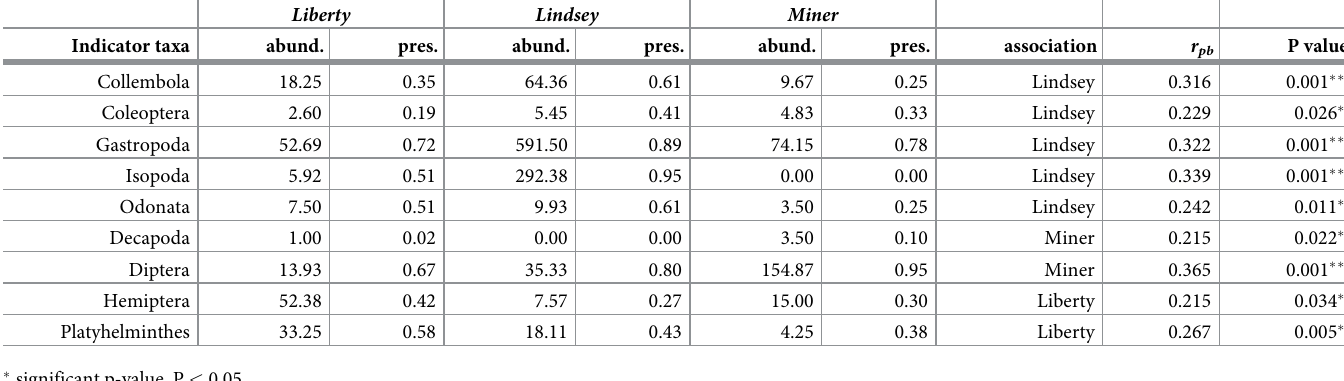
Table 7. Taxa which were significantly associated with a particular area mean abundance by group (abund.), proportion of samples where taxa was present (pres.), and statistical significance of the association. Liberty Lindsey Miner Indicator